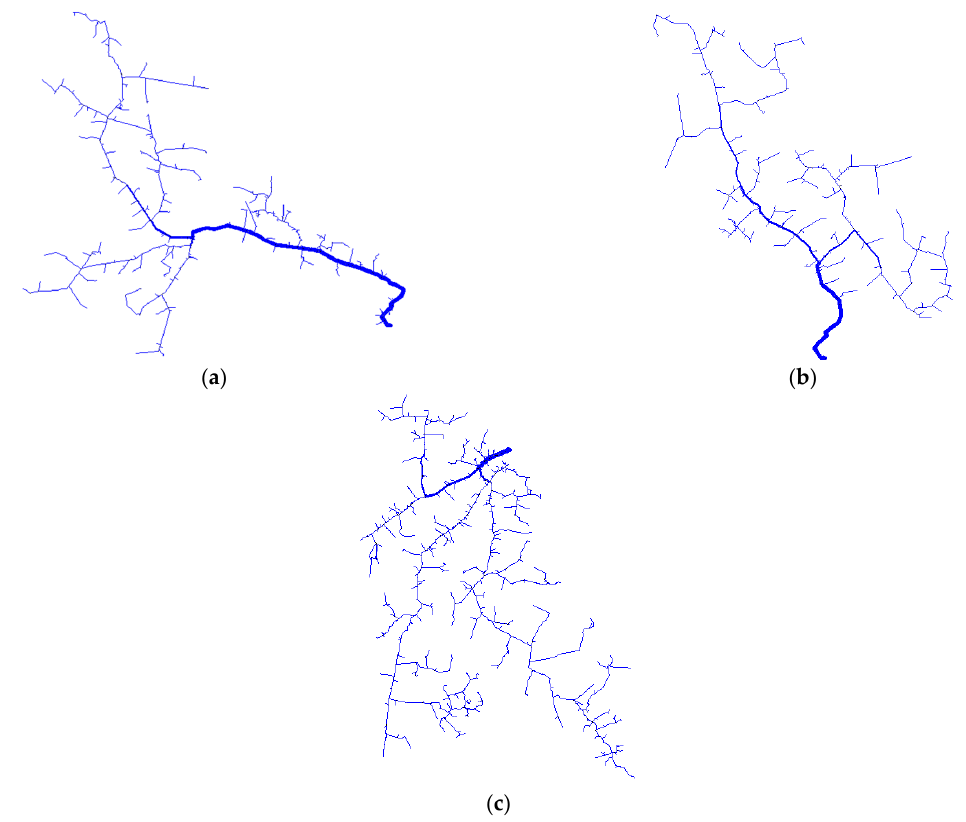
Figure 8. Circuit of ( a ) Rural Feeder A, ( b ) Rural Feeder B, and ( c ) Rural Feeder C. Source: The authors. Table 3. Rural feeders’ technical features. Source: The authors.